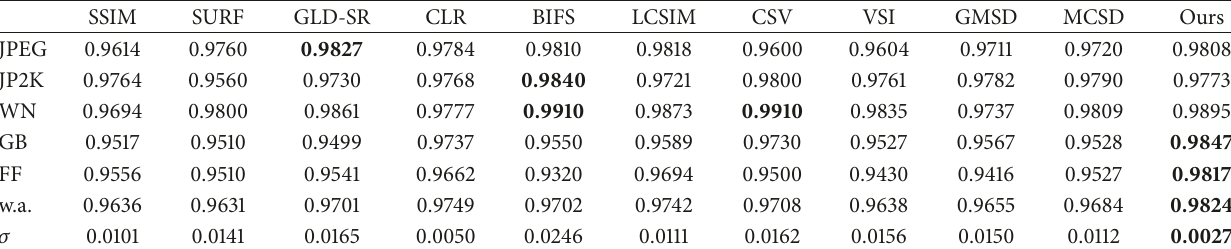
Table 4: SRCC of the proposed method with others for all five individual distortion types on LIVE